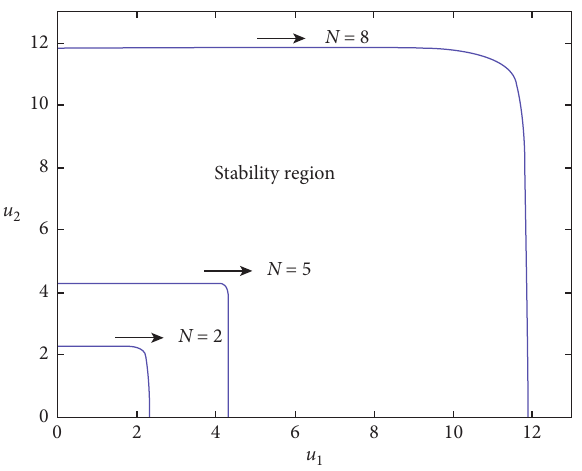
Figure 6: Stability region with a variable N